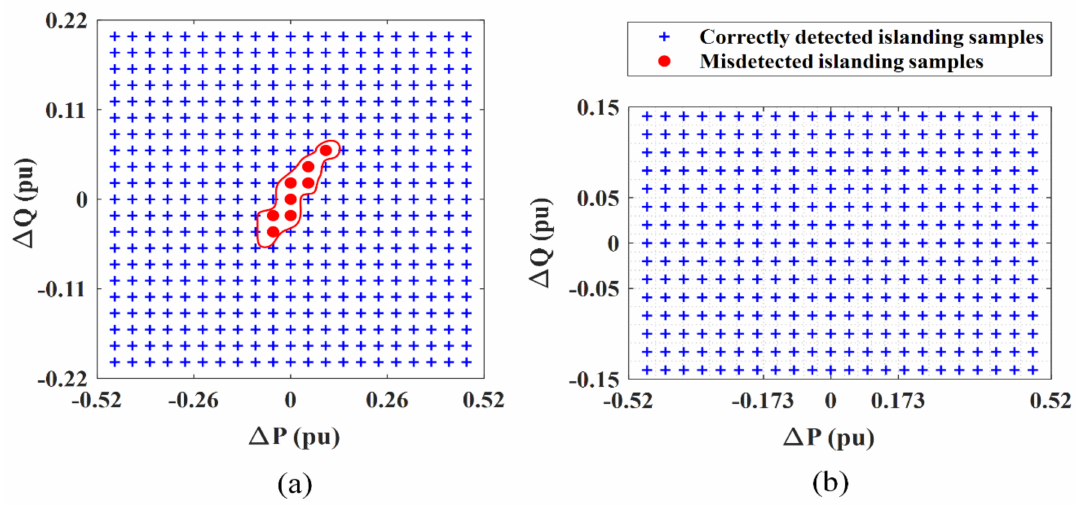
Figure 7. NDZ of the proposed IIDS for ( a ) synchronous based DERs. ( b ) inverter based DERs.